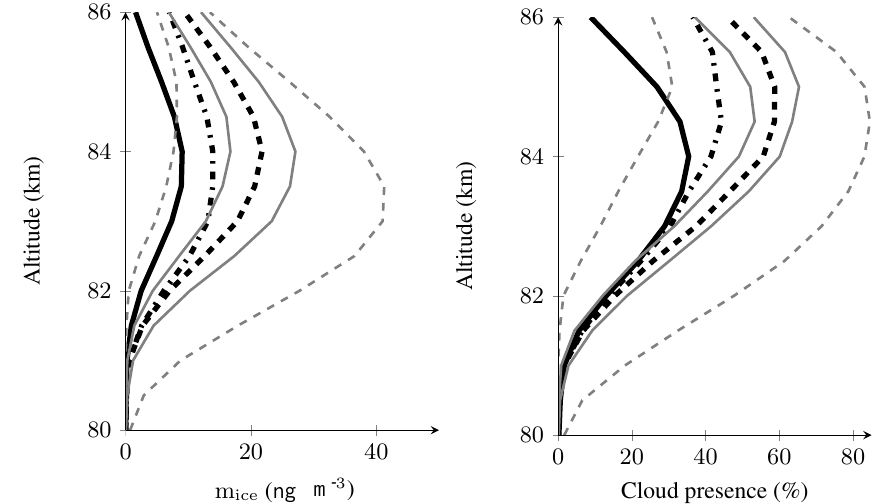
Figure 2. Cloud properties in equilibrium with the atmosphere measured by SMR compared to the OSIRIS measurements. The left plot shows the ice mass density inferred from SMR and OSIRIS according to Eq. (5) (black dashed) and the result if only P gas is used in Eq. (5) (black dotted/dashed). The black solid line shows the ice mass density measured by OSIRIS. The right plot shows the cloud presence for the same data. The thin grey lines are the results if the calculations using P tot are carried out with a modified atmosphere of ± 5K (dashed) and ± 20% water vapour (solid).